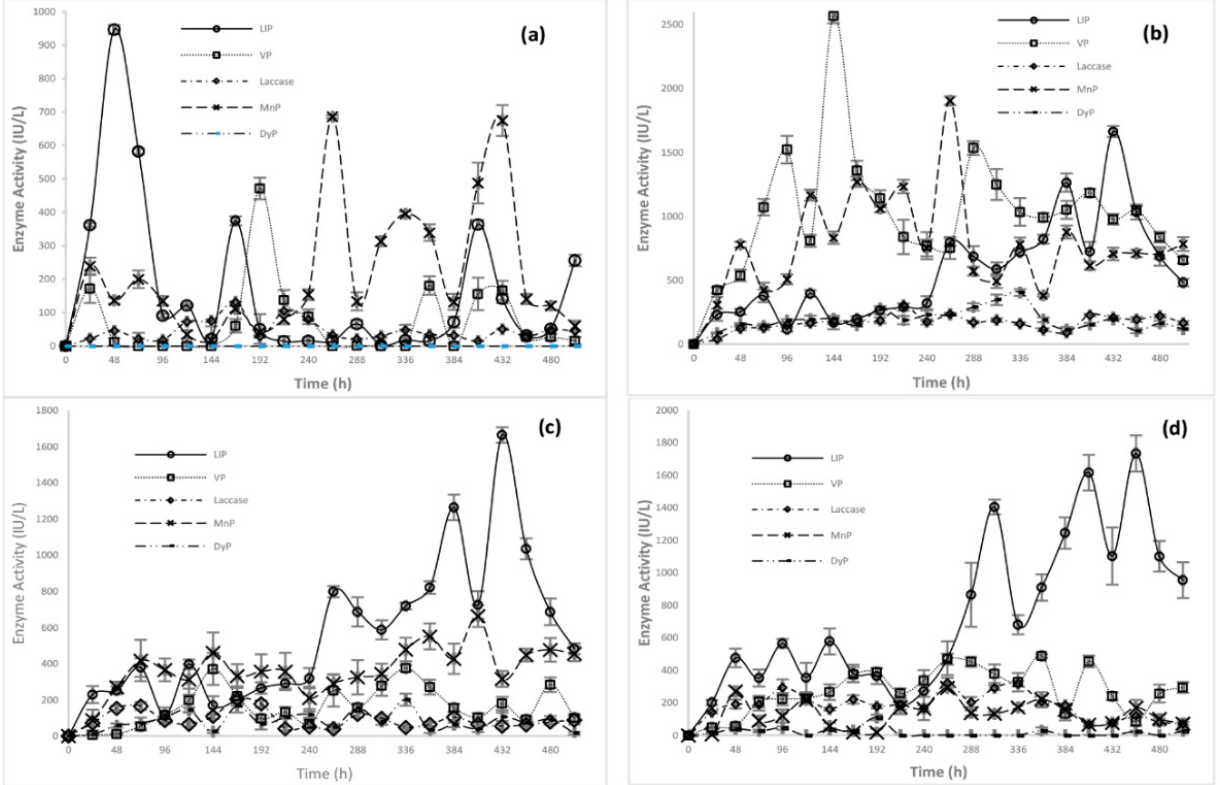
Figure 5. Effect of AYG dye and wheat straw extract on ligninolytic enzyme activity profiles. Time course for the extracellular ligninolytic enzyme activities of Emmia latemarginata as obtained in submerged fermentation conditions with ( a ) Basal medium, ( b ) Basal medium + AYG, ( c ) Basal medium + wheat straw, and ( d ) Basal medium + wheat straw + AYG. The error bars represent the standard deviation for the three different fermentation runs.